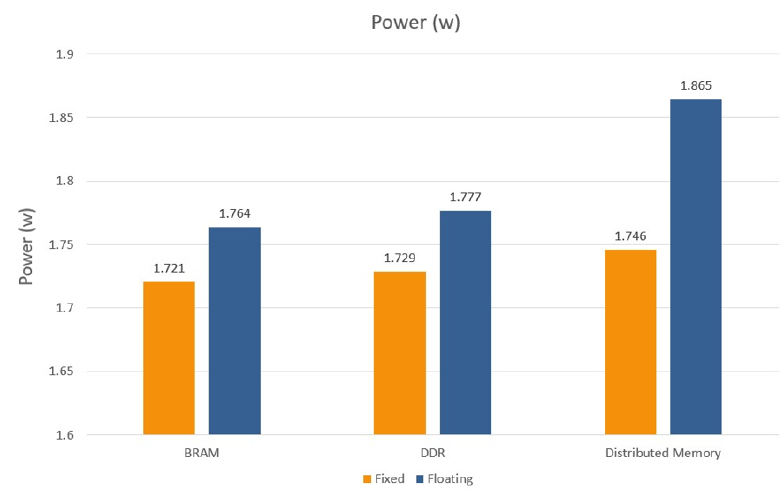
Figure 13. Total system